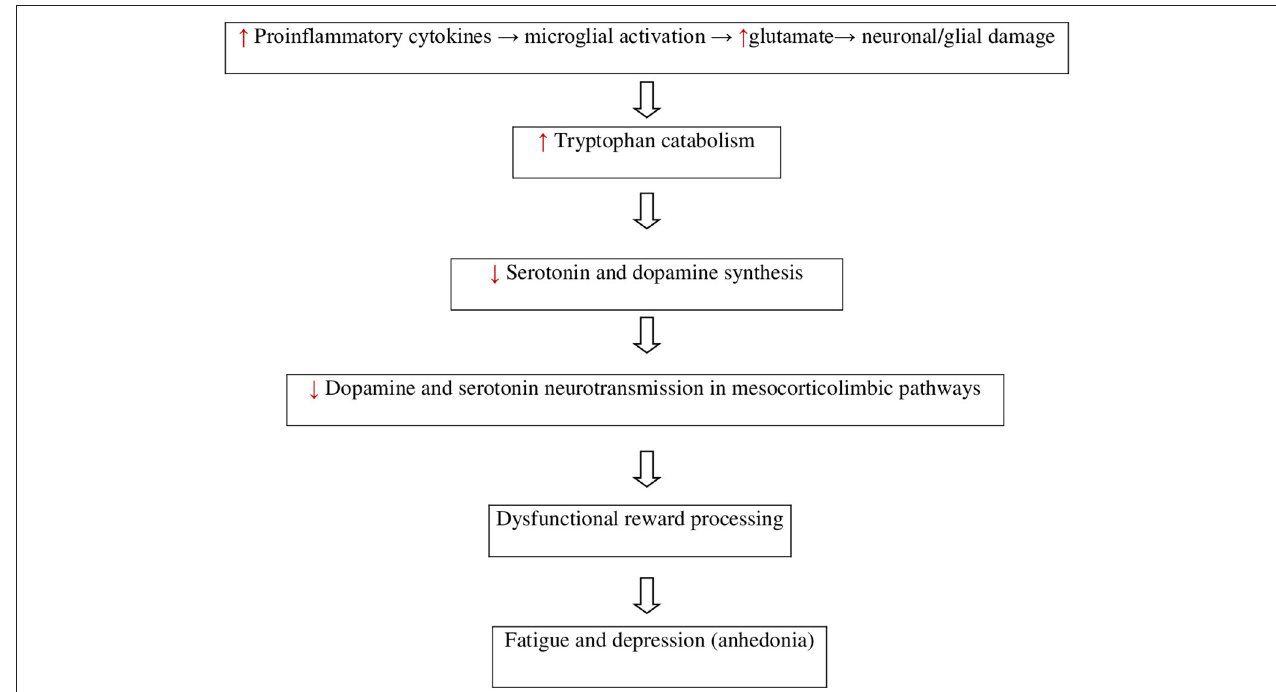
FIGURE 1 | Neuroimmunological finding in MS-related fatigue and